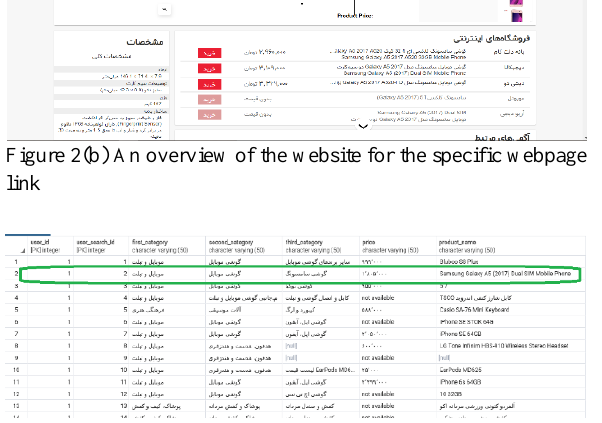
Figure 2(d) The numeric user searches table in the database Table 1-Category types of the website (www.